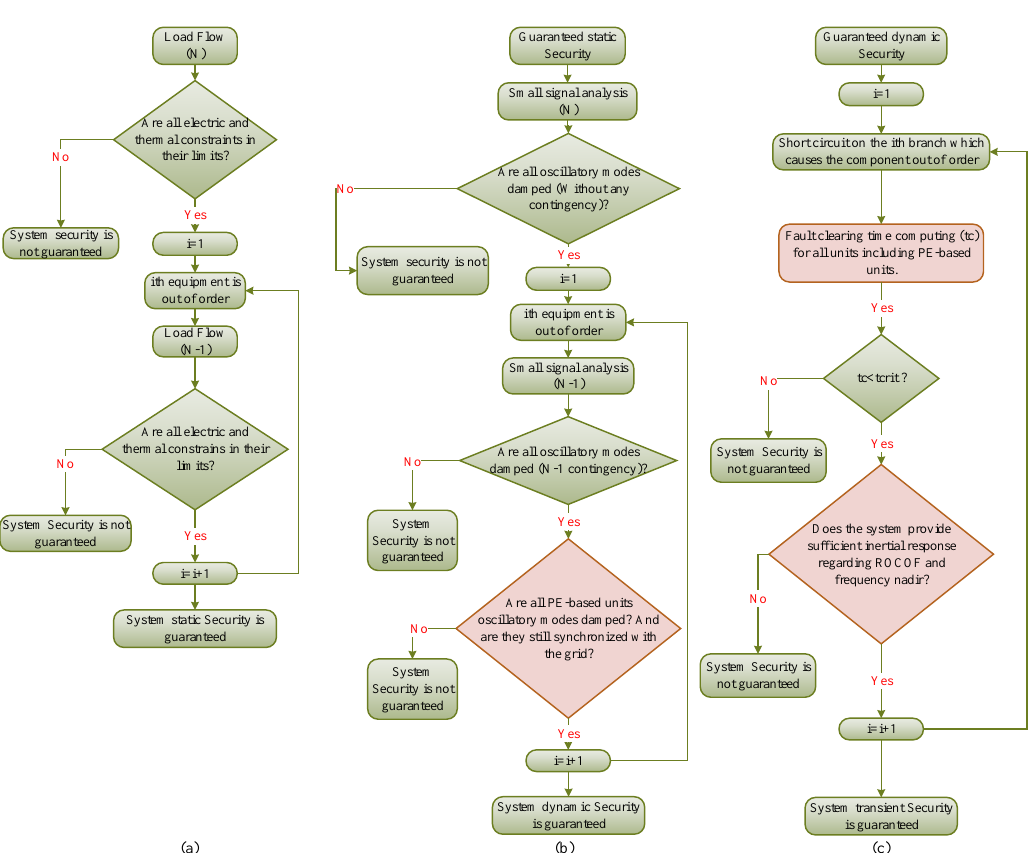
Figure 3. PE-based power system security assessment. ( a ) Static security assessment, ( b ) dynamic security assessment, ( c ) and transient security